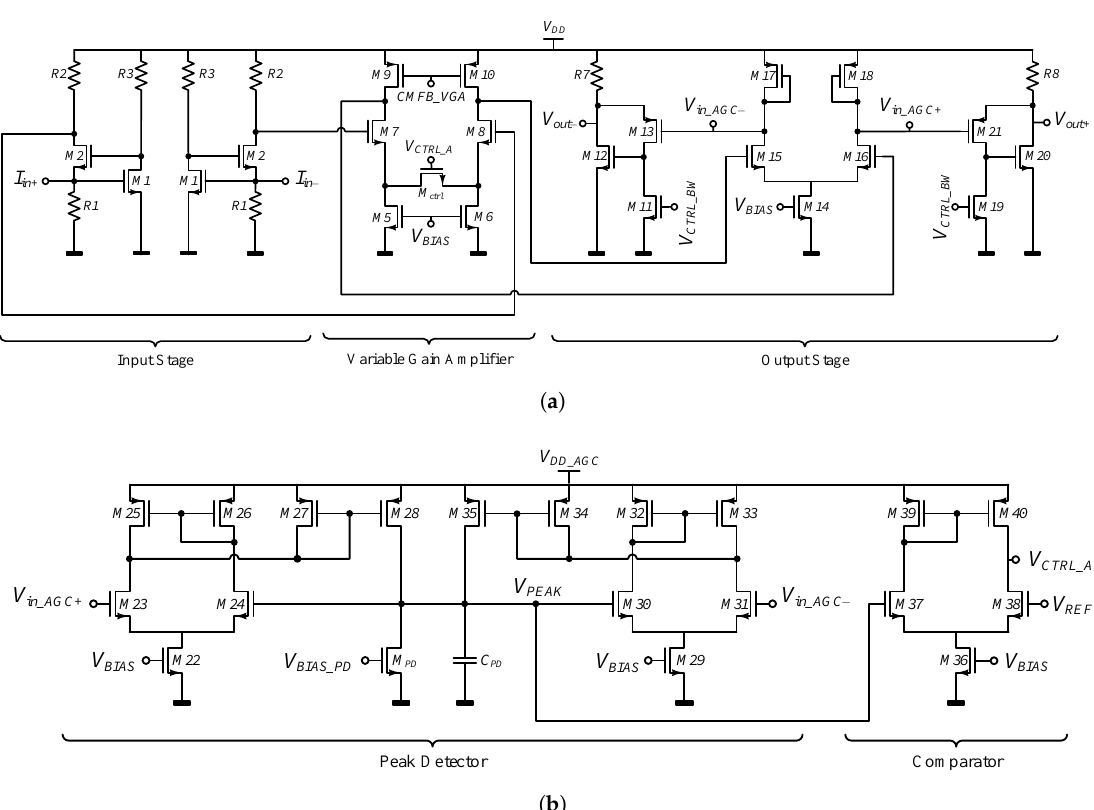
Figure 4. Circuit schematic of: ( a ) the proposed fully differential TIA design, and ( b ) the AGC. The gain of the TIA needs to be high enough to compensate for the motional resistance of the MEMS resonator and sustain the oscillation. The regulated cascade (RGC) topology [30] was chosen